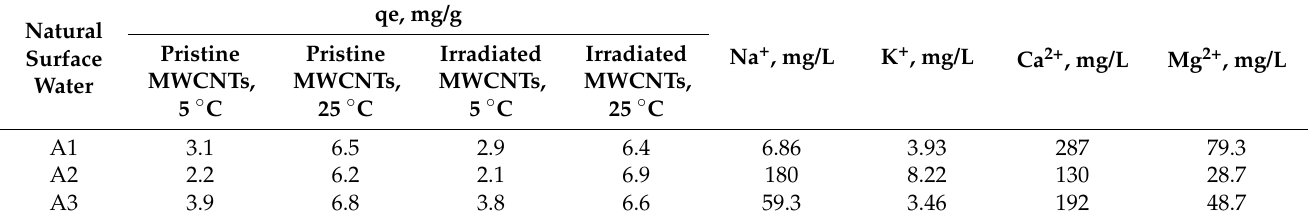
Table 4. Influence of Na + , K + , Ca 2+ , and Mg 2+ cations on TCC adsorption on MWCNTs at 5 ◦ C and 25 ◦